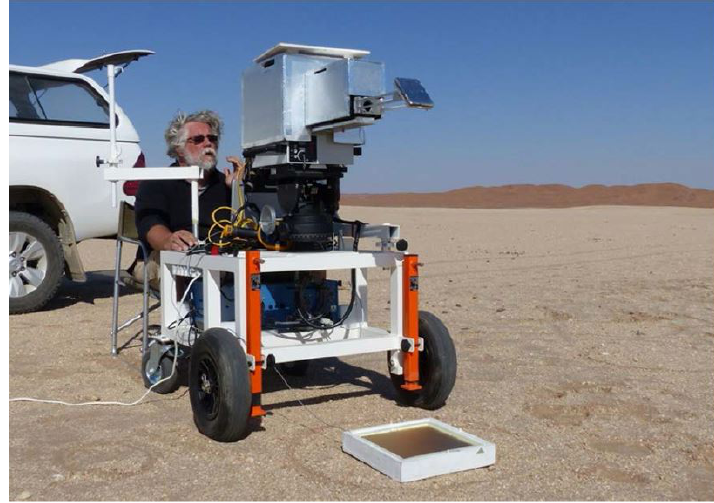
Figure 3. Instrumentation setting used for in situ measurements of emissivity soundings.